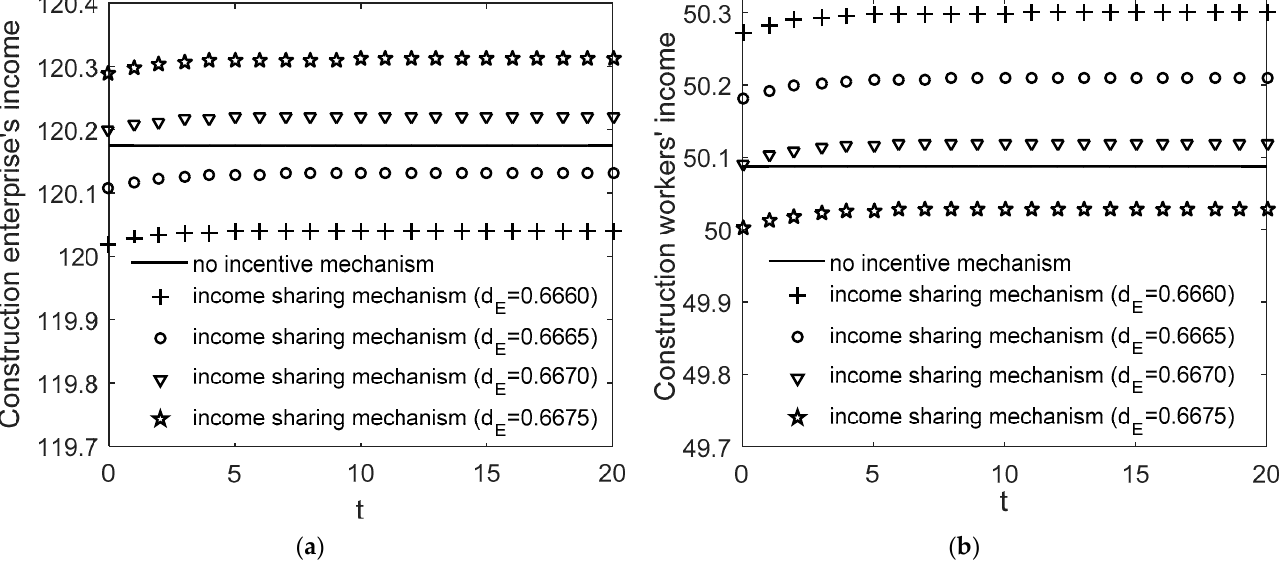
Figure 5. Influence of d E on the income of the construction enterprise and construction workers: ( a ) Construction enterprise’s income; ( b ) Construction workers’ income.